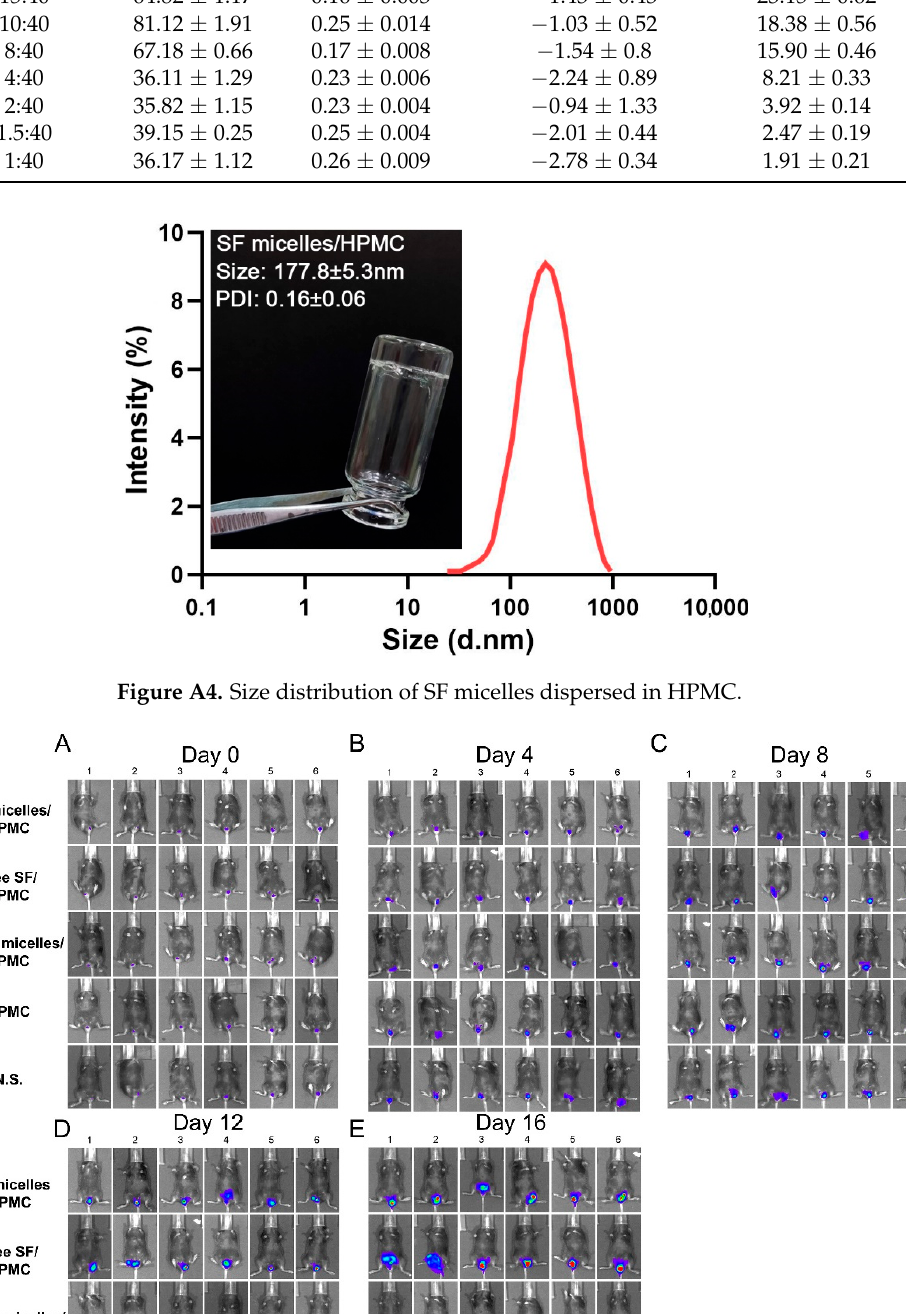
Figure A6. Photographs of orthotopic cervical carcinoma connecting uterus and uterine tubes at the end of treatment.